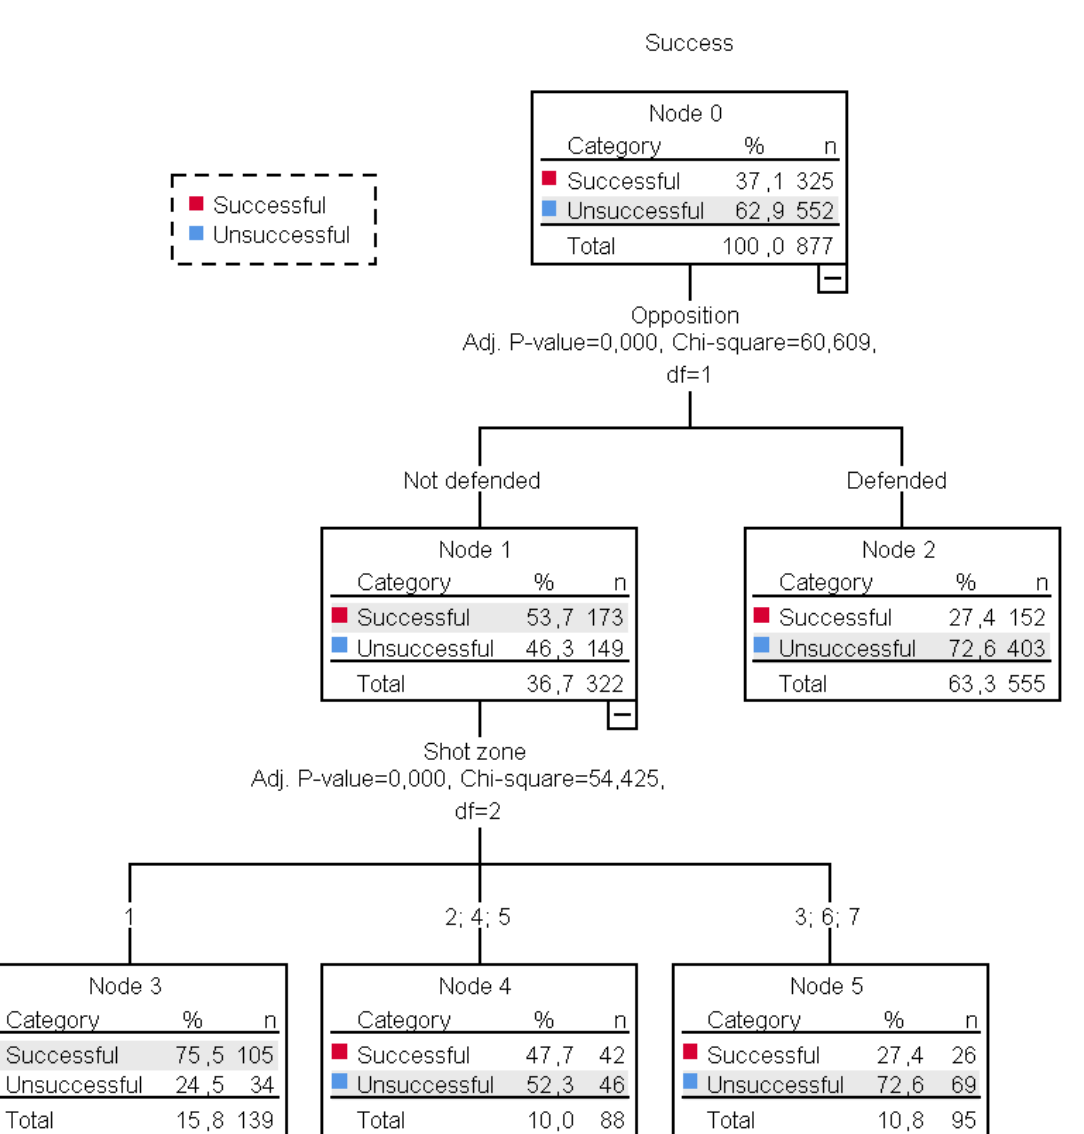
Figure 2. Level of opposition and shot zone as key variables in predicting shot success.